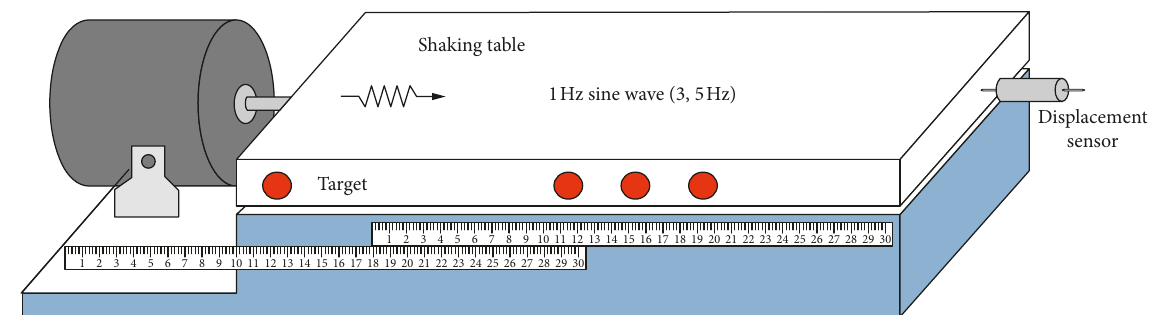
Figure 5: The verification test system of the vision-based displacement test method.